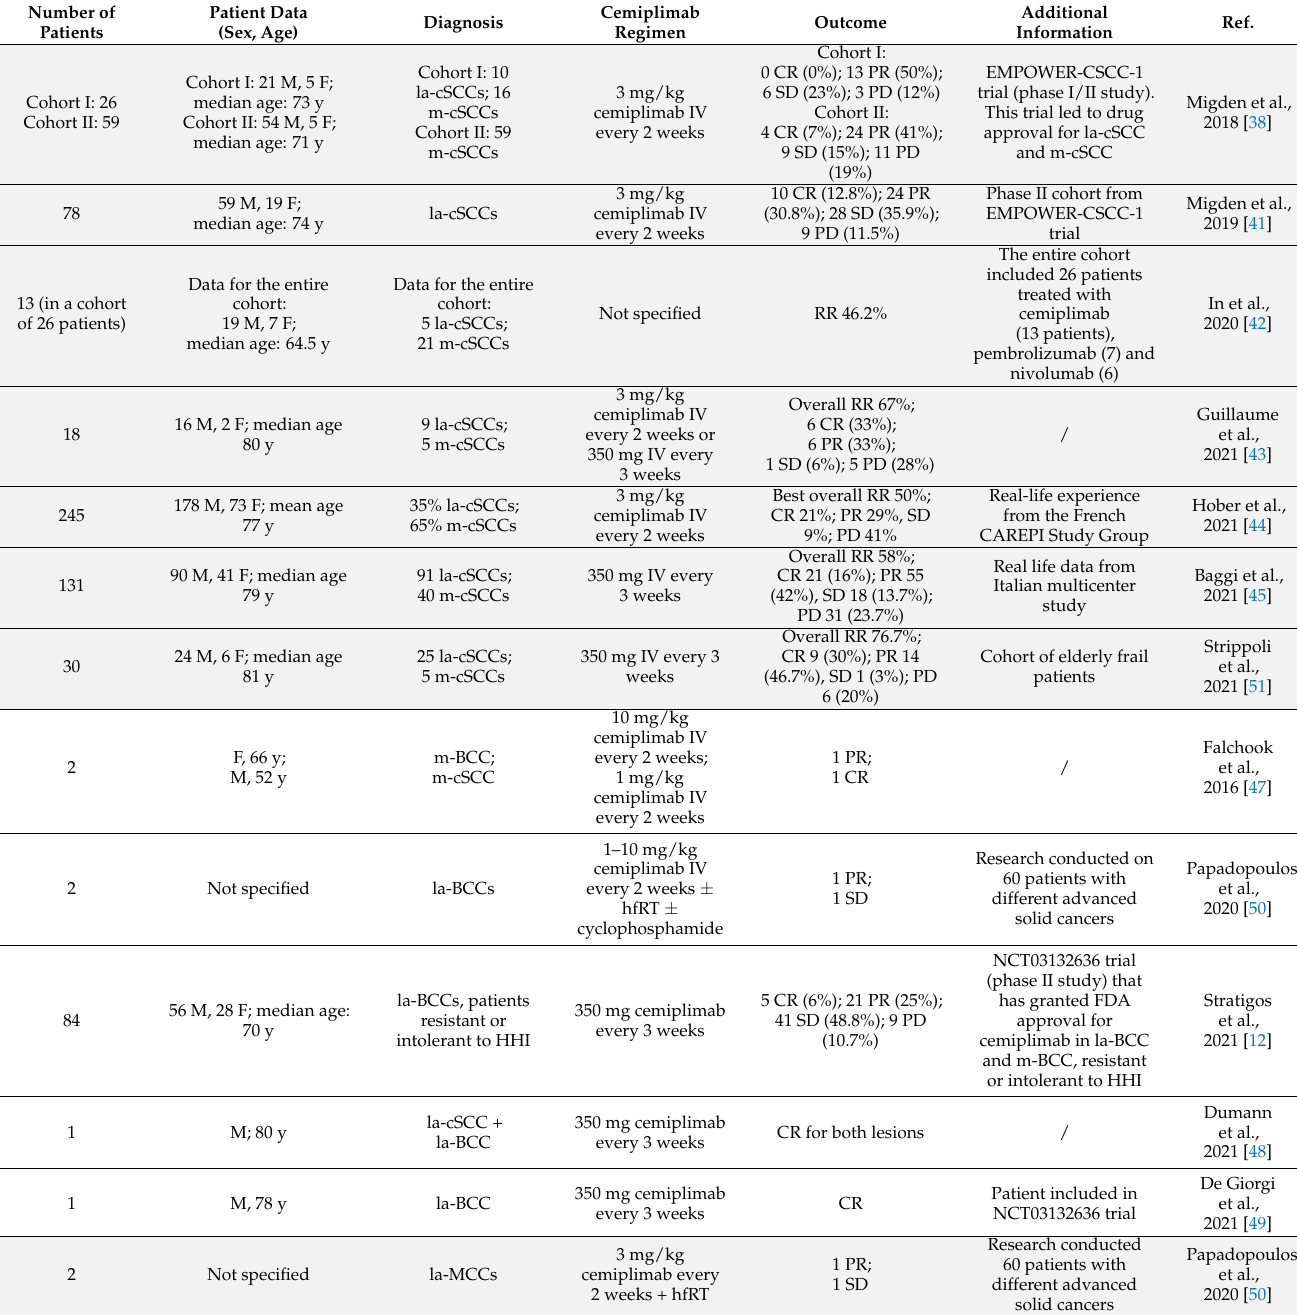
Table 2. Reported cases of locally advanced and metastatic non-melanoma skin cancers treated with